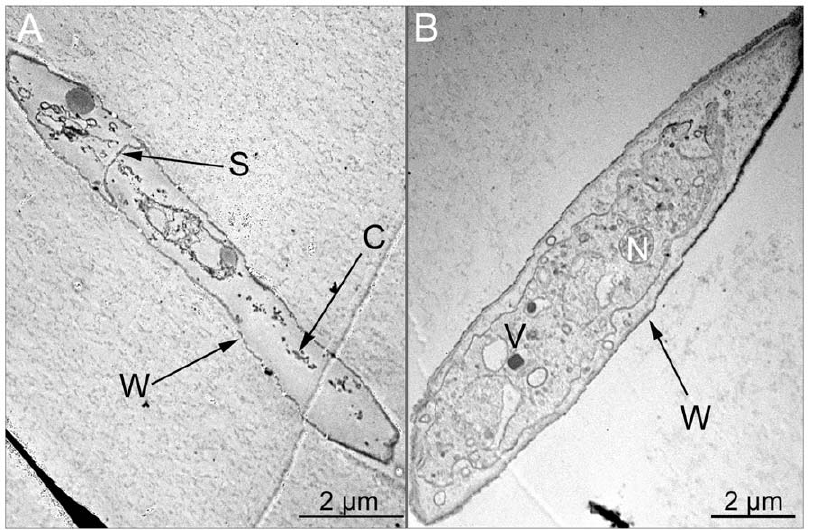
Figure 4. Transmission electron micrographs of the hyphae of F.oxysporum from dual or single culture. (A) F. oxysporum mycelium from dual culture with the endophyte. (B) F. oxysporum mycelium control. Transmission electron micrographs of the mycelium of F. oxysporum from dual or single culture on agar plate with the endophyte P. variabile (14 days, 27 u C) and showing cell death in the presence of the endophyte. N: nucleus. W: wall. S: septum. C: cellular fragments. V: vesicule.